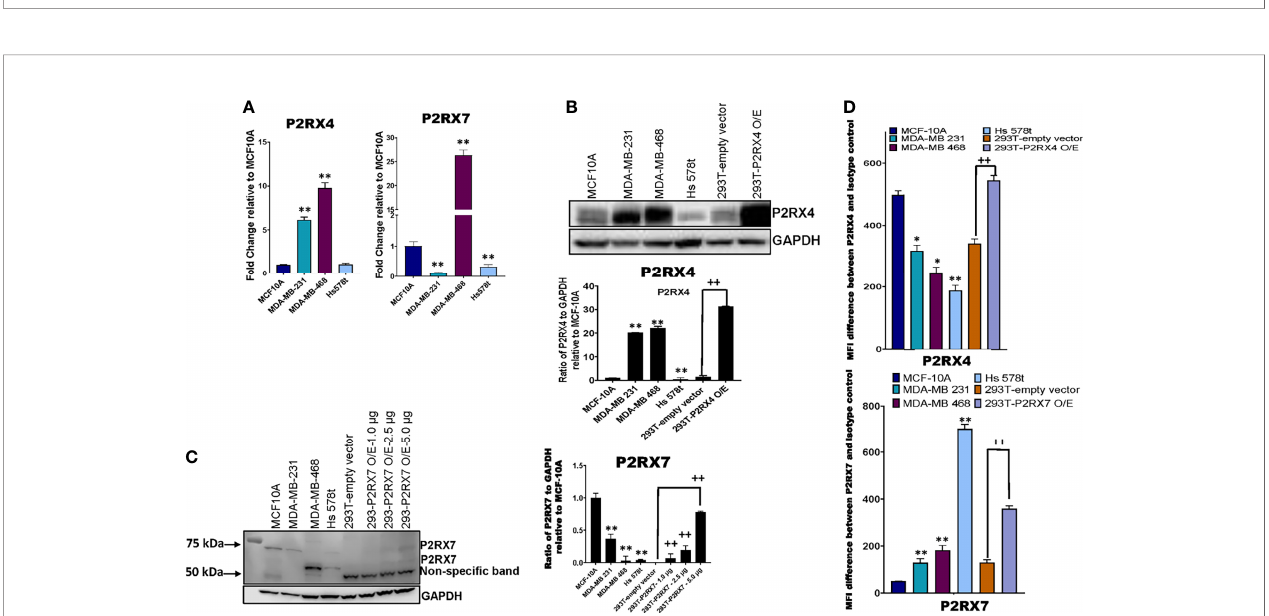
FIGURE 6 | mRNA and protein expression analysis of P2RX4 and P2RX7 for all cell lines. (A) qRT-PCR was performed on mRNA of TNBC cell lines and MCF-10A cells using speci fi c primers for P2RX4 and P2RX7. * represents p < 0.05 and ** represents p < 0.01. TNBC cell lines, MCF-10A cells, and HEK 293T cells transfected with P2RX4 or P2RX7 as positive controls were probed for (B) P2RX4 and (C) P2RX7, and GADPH was used as a loading control for western blot analysis repeated twice. HEK 293T cells transfected with P2RX7 were loaded at increasing protein concentrations of 1.0 µg, 2.5 µg, and 5.0 µg combined with lysates of control vector-transfected cells to keep the total loaded protein the same in each lane. Densitometry analysis was performed using Image Studio on the 75 kDa P2RX7 band. The student ’ s t-test was applied to the applicable assays to ascertain signi fi cance. * represents p<0.05 and ** represents p < 0.01 relative to MCF-10A; + represents p < 0.05 and ++ represents p < 0.01 relative to HEK293-empty vector transfected. (D) The calculated difference in mean fl uorescence intensity (MFI) values between TNBC cell lines, MCF-10A cells, and HEK 293T cells transfected with P2RX4 or P2RX7 as positive controls stained with P2RX4 or P2RX7 speci fi c antibody and the isotype control for the different cell lines examined. * represents p < 0.05 and ** represents p < 0.01 relative to MFI difference in MCF-10A cells; + represents p < 0.05 and ++ represents p < 0.01 relative to MFI difference in HEK293-empty vector transfected. O/E represents